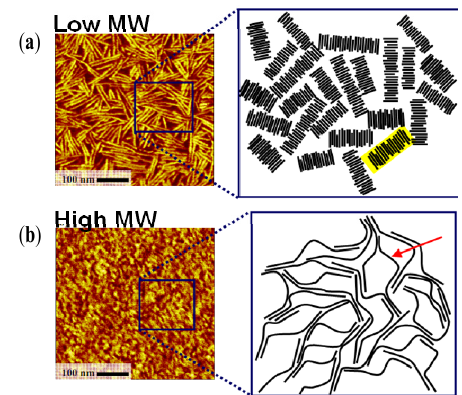
Figure 14. Model for transport in ( a ) low-MW and ( b ) high-MW films. Charge carriers are trapped on nanorods (highlighted in yellow) in the low MW case. Long chains in high-MW films bridge the ordered regions and soften the boundaries (marked with arrow) (Adapted with the permission from [44]. Copyright 2005 American Chemical